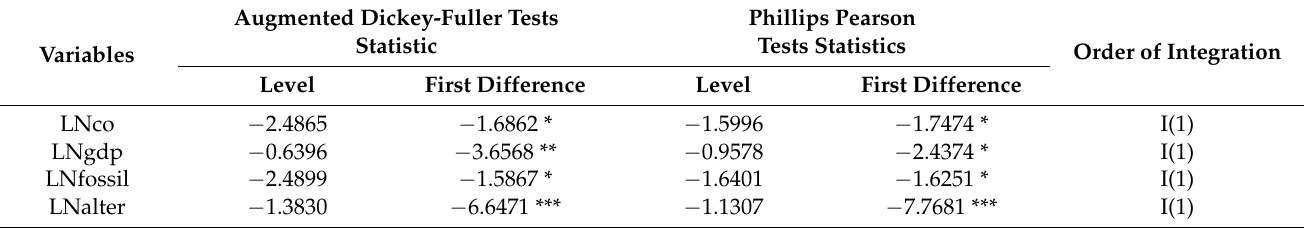
Table 2. Results of unit root tests.